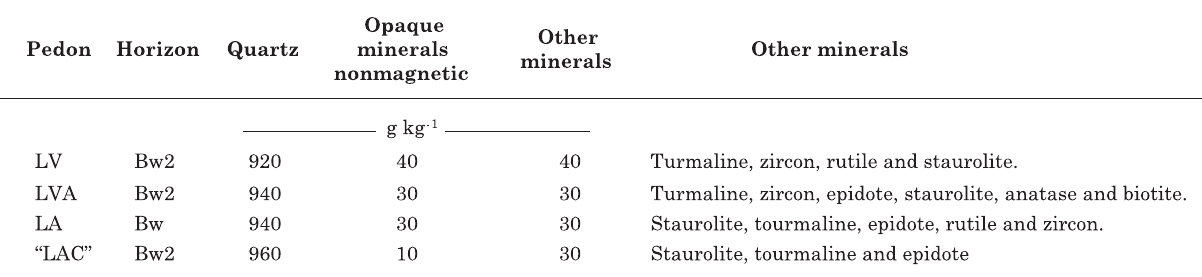
Table 8. Mineralogy of the sand fraction of the Bw horizons of pedons of the